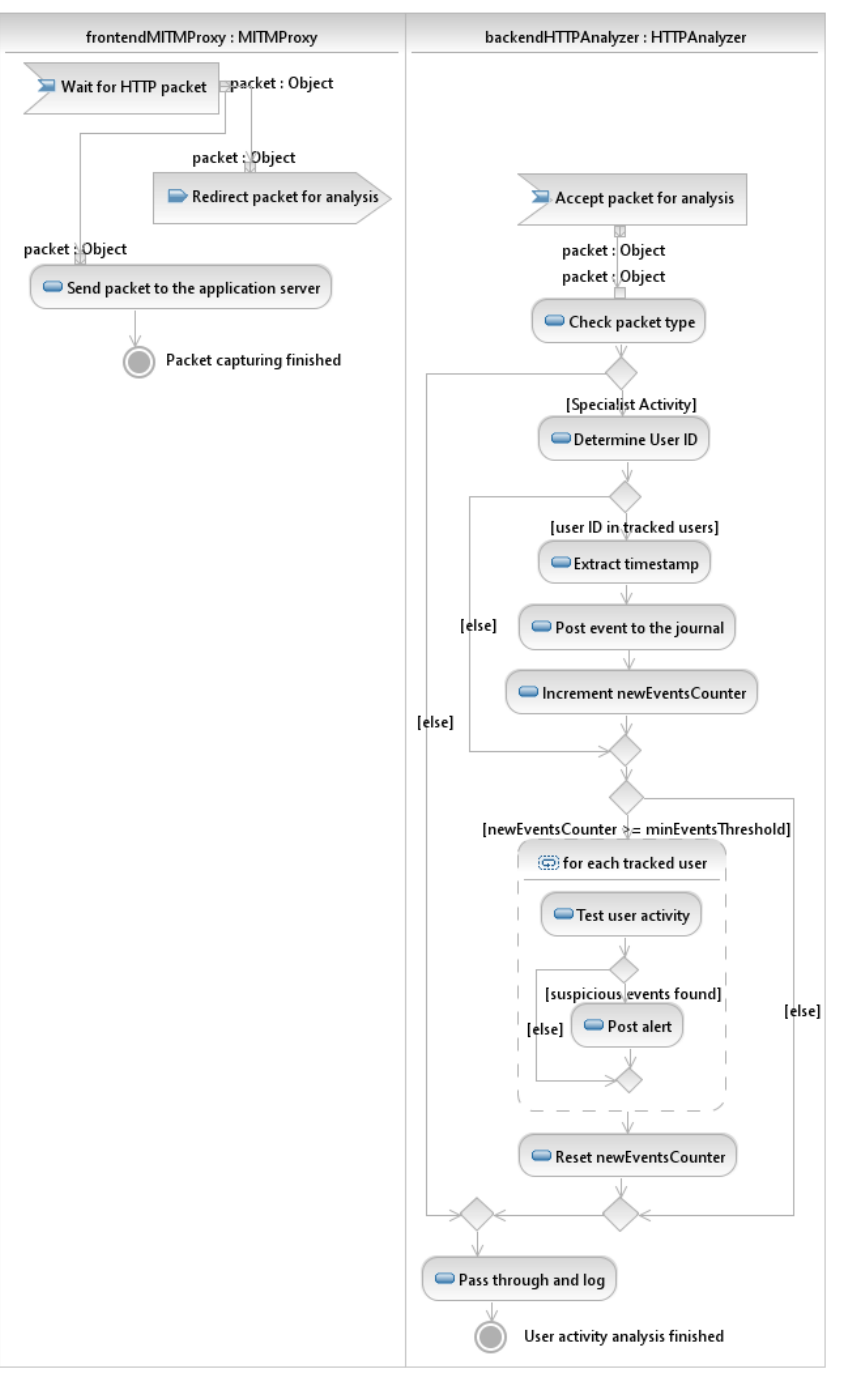
Figure 8. Analysis of user activity.